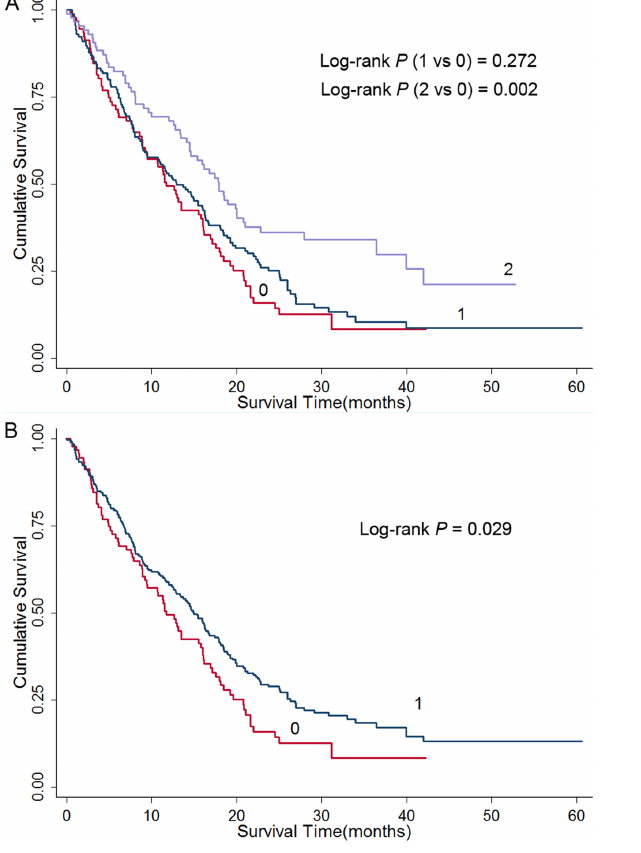
Figure 2. Kaplan-Meier plots of survival by miR-378 rs1076064 genotypes in HCC-specific survival. (A) ‘‘0’’ denotes patients with common genotype (AA); ‘‘1’’ denotes patients with AG; ‘‘2’’ denotes patients with GG; (B) ‘‘0’’ denotes patients with common genotypes (AA); ‘‘1’’ denotes those with variant genotypes (AG/GG).